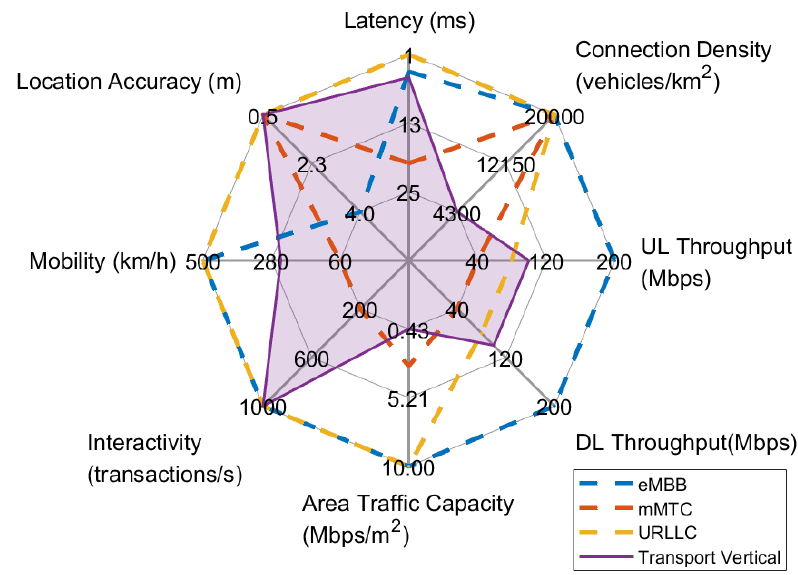
Figure 5. KPIs of the Transport vertical and related 5G service